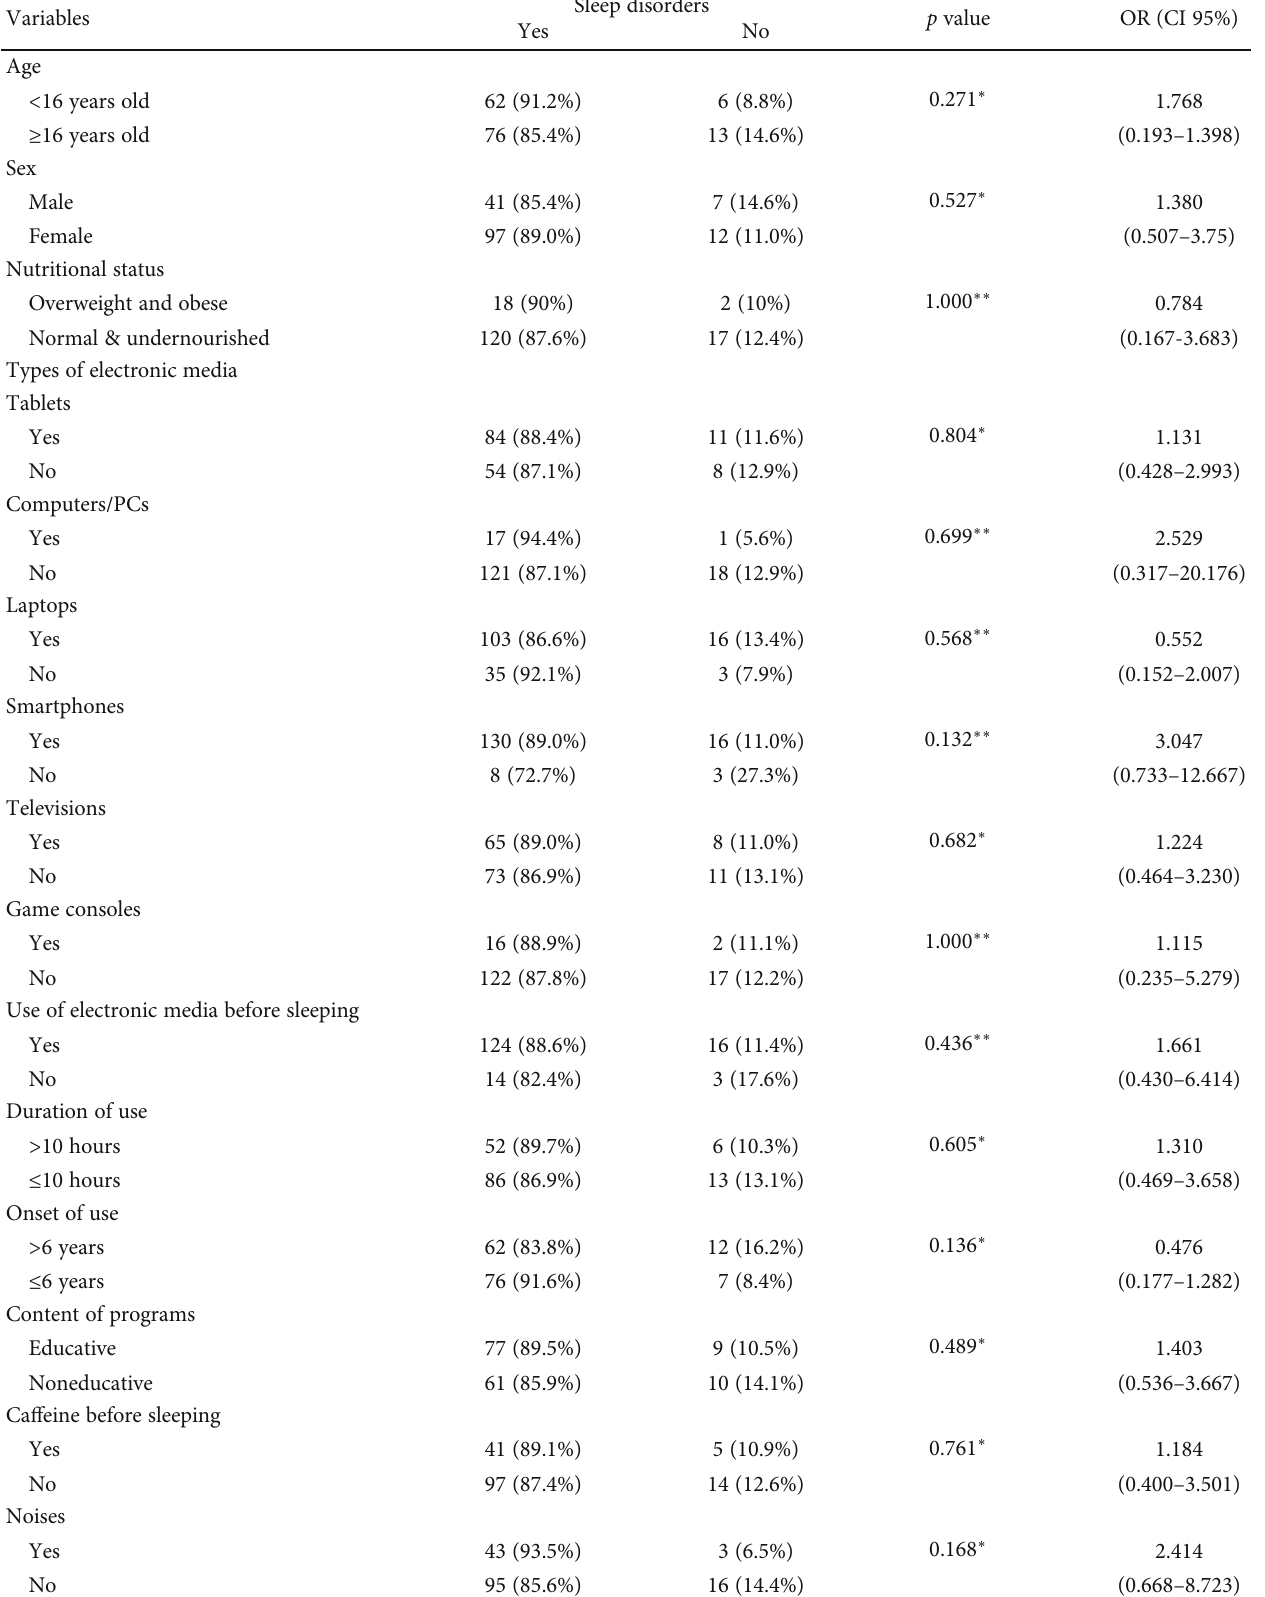
Table 4: Correlation of the participant ’ s characteristics and electronic media use with sleep disorders ( n = 157